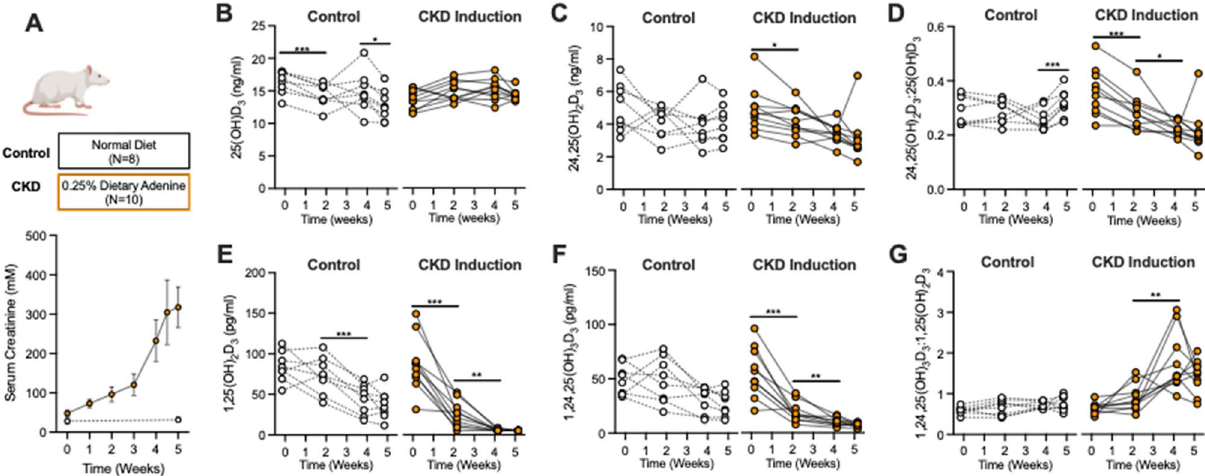
Figure 3. Longitudinal vitamin D measurements from a rat model of CKD mirrors human 1,24,25(OH) 3 D 3 profile. ( A ) Experimental design and longitudinal elevation in serum creatinine in CKD rats compared to control. Mean/SD. ( B ) 25(OH)D 3 , ( C ) 24,25(OH) 2 D 3 , ( D ) 25-VMR 24,25(OH) 2 D 3 :25(OH)D 3 , ( E ) 1,25(OH) 2 D 3 , ( F )